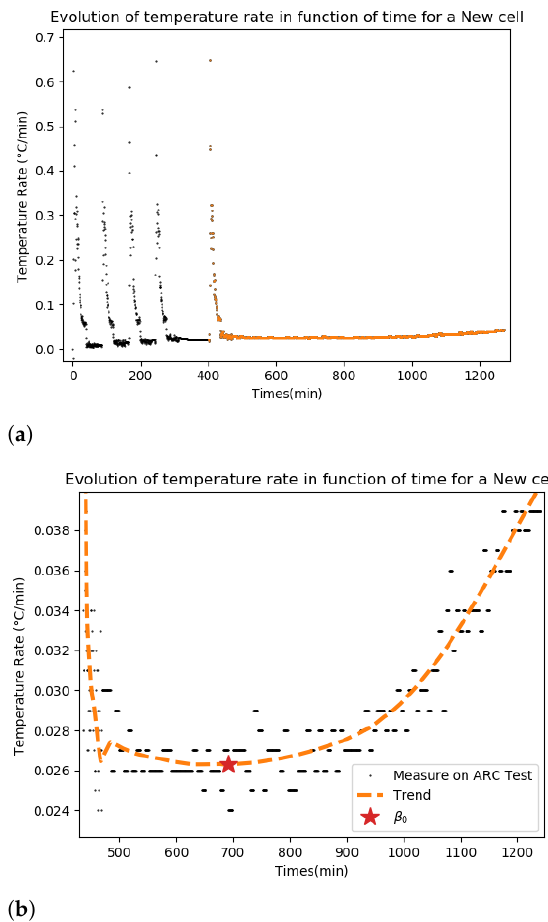
Figure 1. Location of onset temperature. ( a ) Example of heat rate measured during an ARC test on a new cell. ( b ) Example of situation of the onset